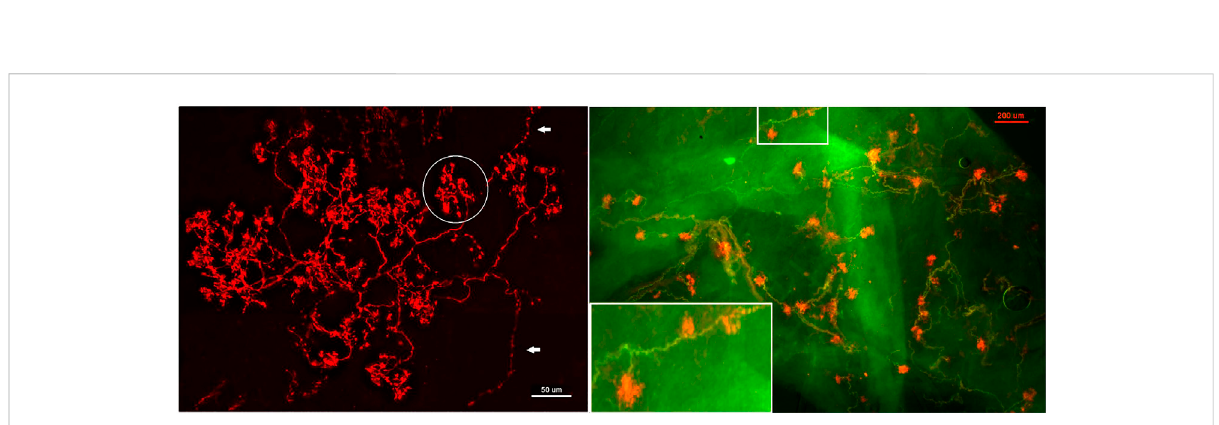
FIGURE 8 Aortic baroreceptor structures. Left: sensory structures in compact clusters resembling bunches of grapes. Their terminals swell to form knob- like or leaf-like end-formations. A single parent axon may connect with multiple sensory receptor structures, indicated by white arrows. Circled in white is a single BR (a compact CUE). The scale bar is 50 μ m. Right: a double staining approach to illustrate BR structures. Na + /K + -ATPase stains all structures in the sensory unit (red) and myelin basic protein (MBP) stains the myelin sheath (green). Each red ball shaped end-formation (a compact CUE) is a BR, demonstrated by a myelinated axon termination. The lower left corner is an enlargement of the structure in the upper middle rectangle. The scale bar is 200 μ m [Figure 1 and Figure 2 (Liu et al.,